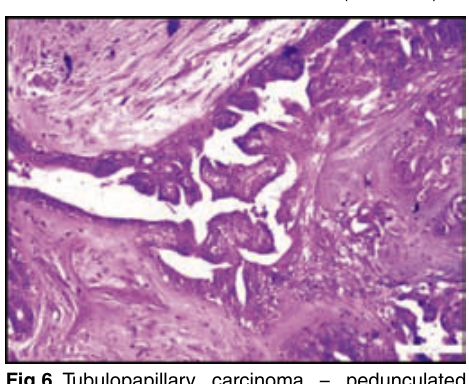
Fig.5. Comedocarcinoma - presence of necrotic areas within the centre of the neoplastic cell aggregates (H&Ex200)